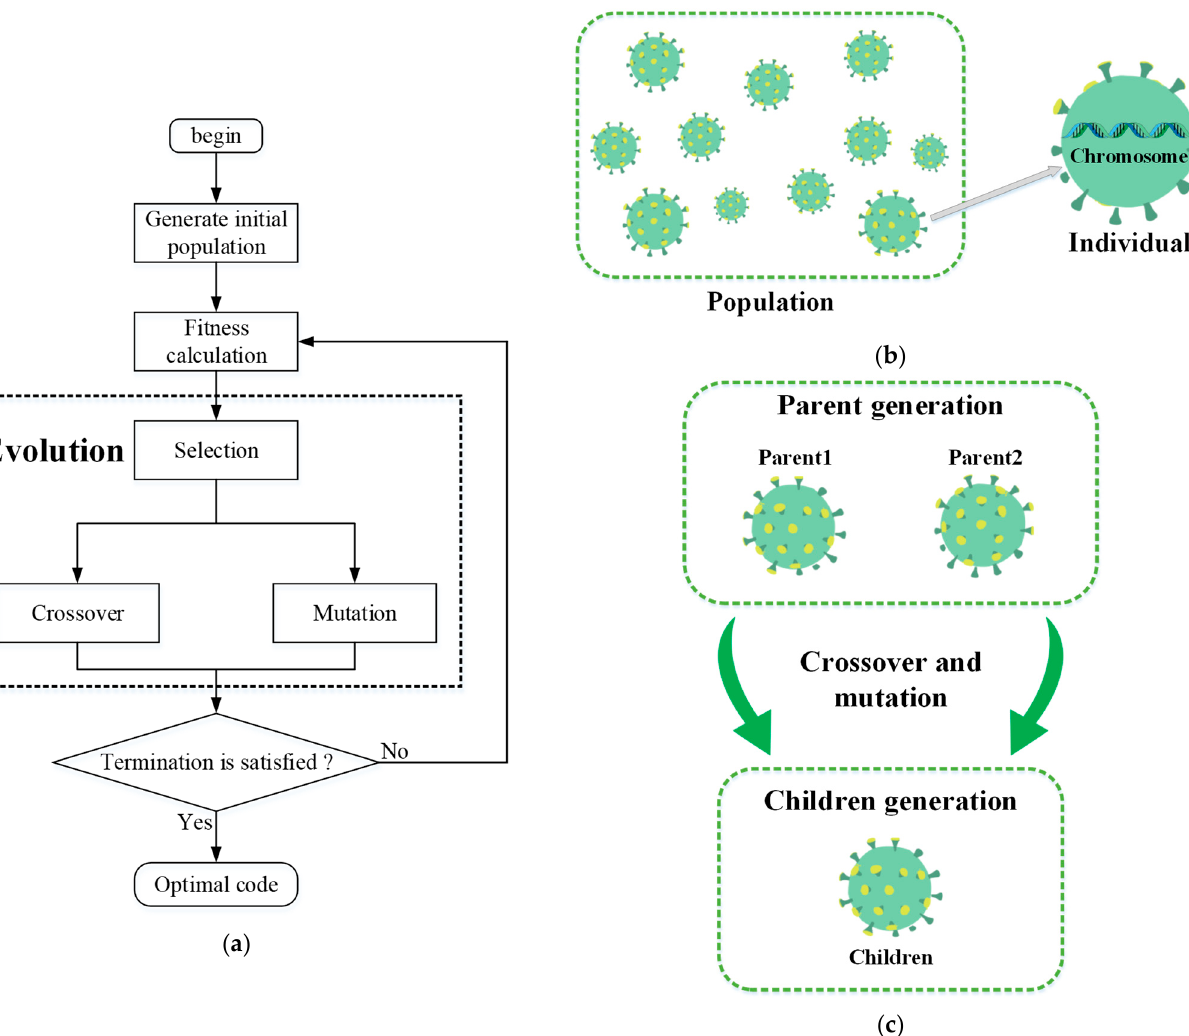
Figure 4. ( a ) Flowchart of GA; ( b ) Population, individuals, and chromosomes; ( c ) Parent generation produces children generation through crossover and mutation.